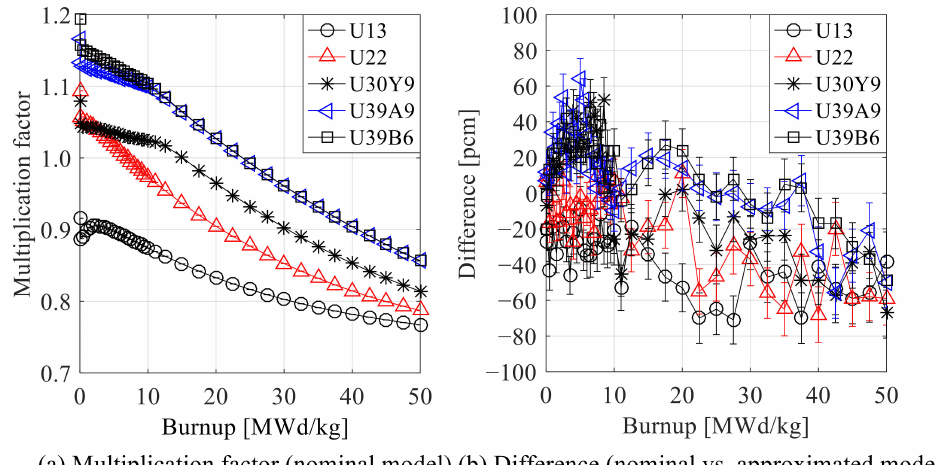
Figure 4. Differences between nominal models and approximated models with Serpent